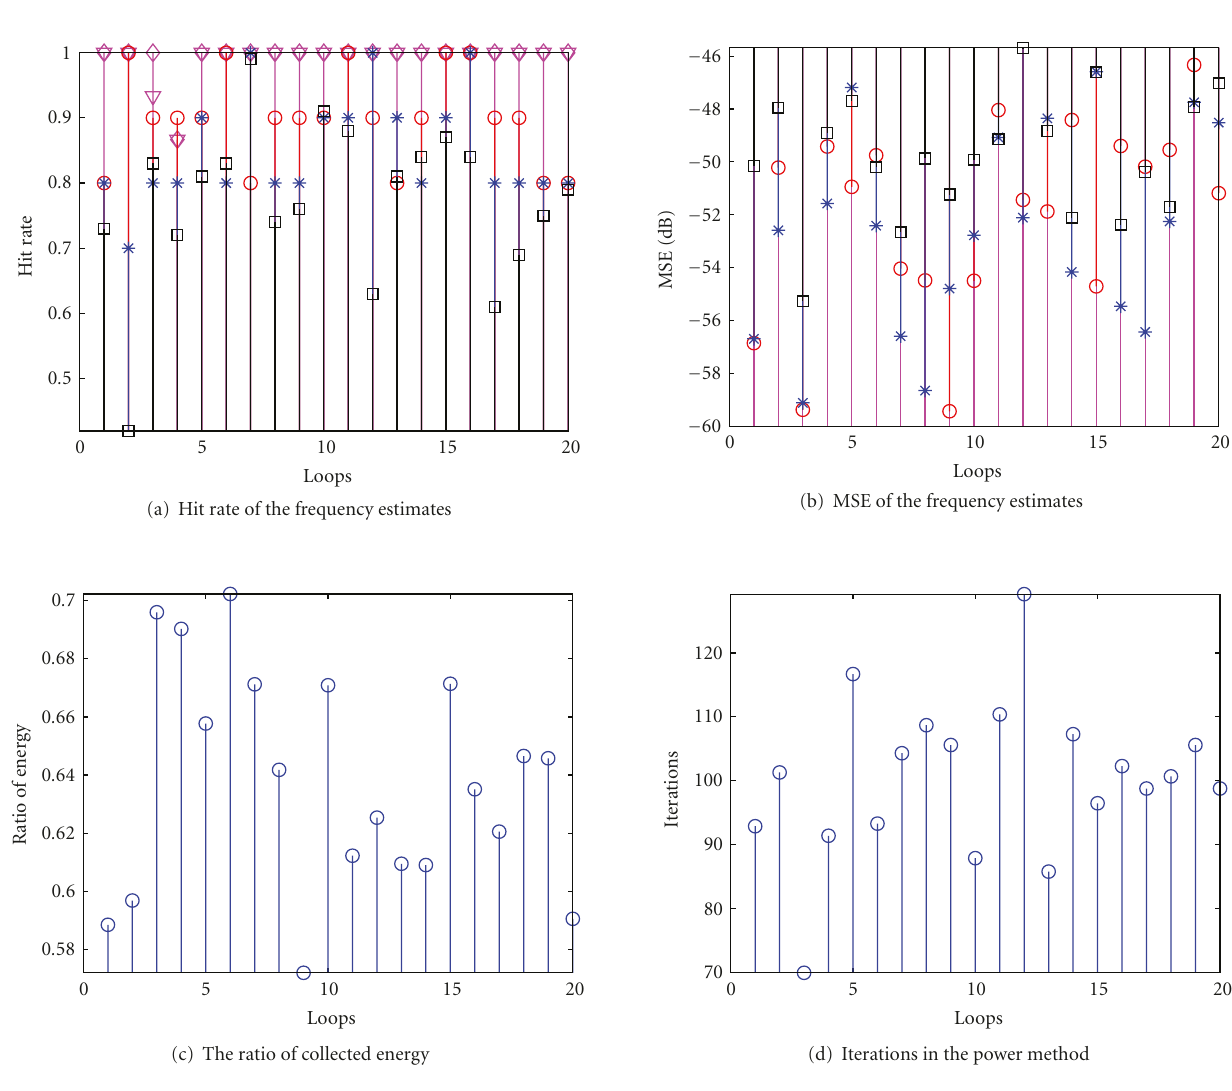
Figure 2: Implementations of A1–A5 in the noise-free case with p = 10, L = 50, and M = 60. Stems marked with diagonals, downward triangles, circles, stars, and squares denote the algorithms A1–A5, respectively. These legends also apply to Figure 3.